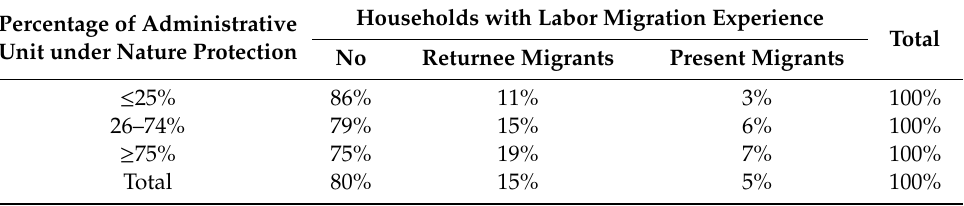
Table 4. Households with labor migration experience located in protected natural